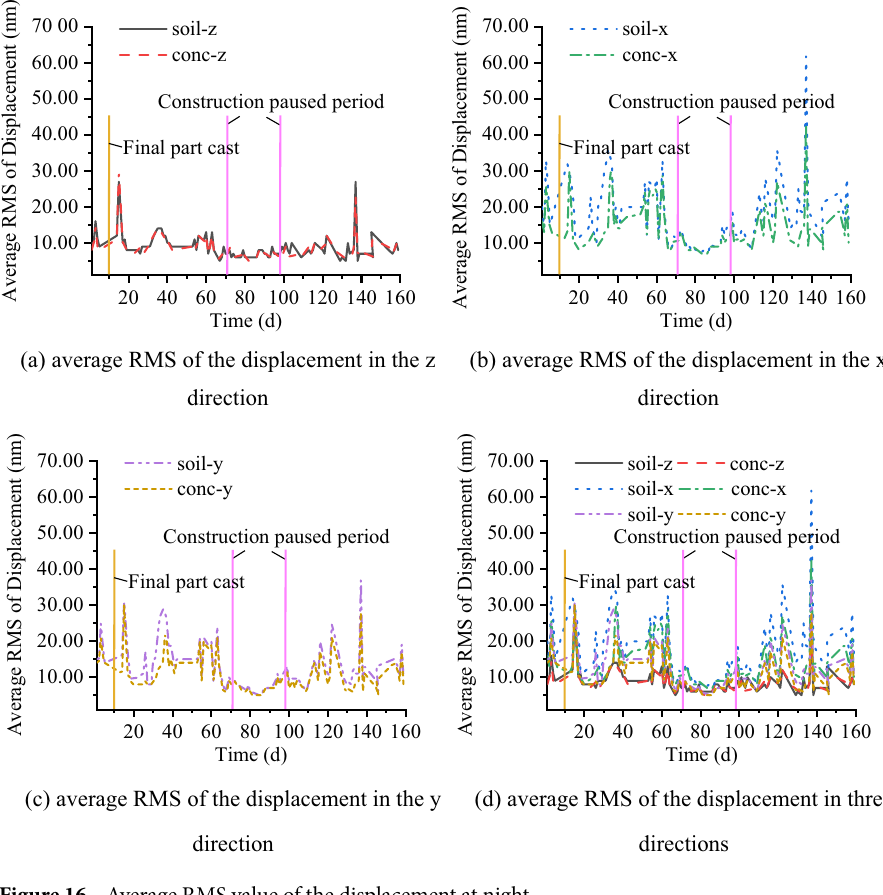
Figure 16. Average RMS value of the displacement at